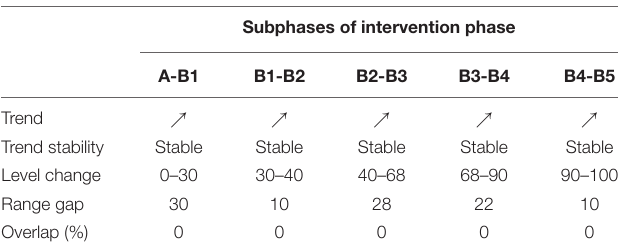
TABLE 3 | Functional communication vocabulary recognition (between subphases).